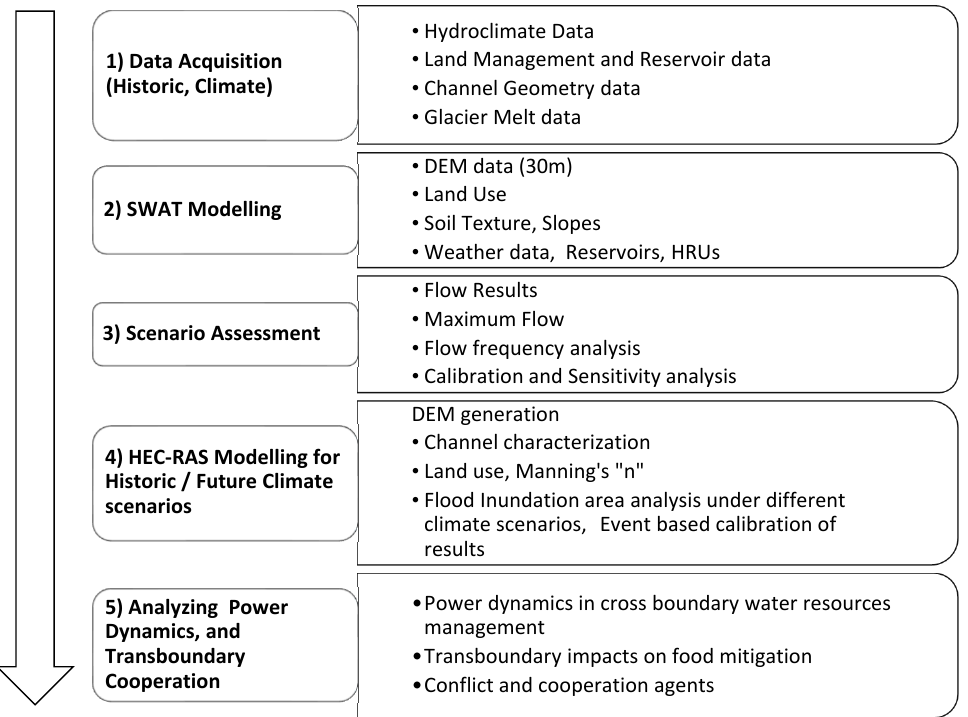
Figure 3. Modelling and conceptualization process.